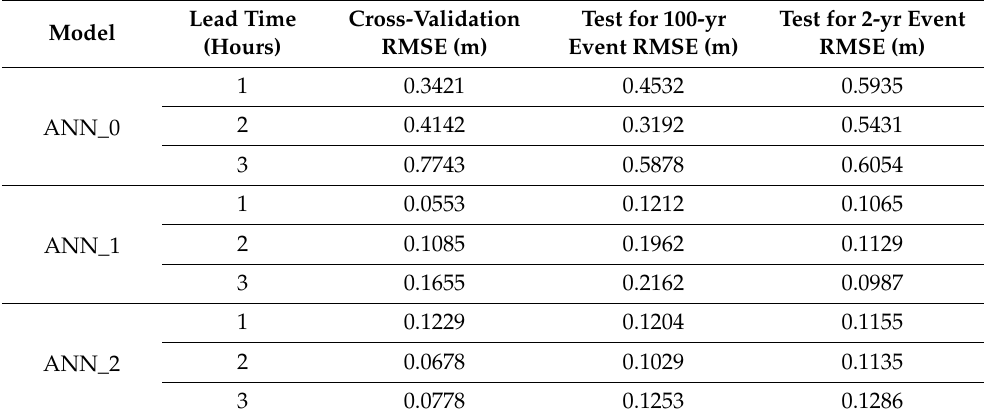
Table 5. RMSEs of different ANN models for the training and testing